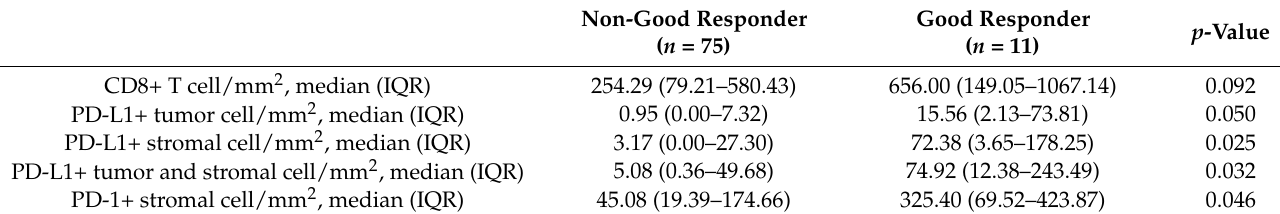
Table 2. Immune profile of the BRAF-MT tumors in the non-good and good responder groups.